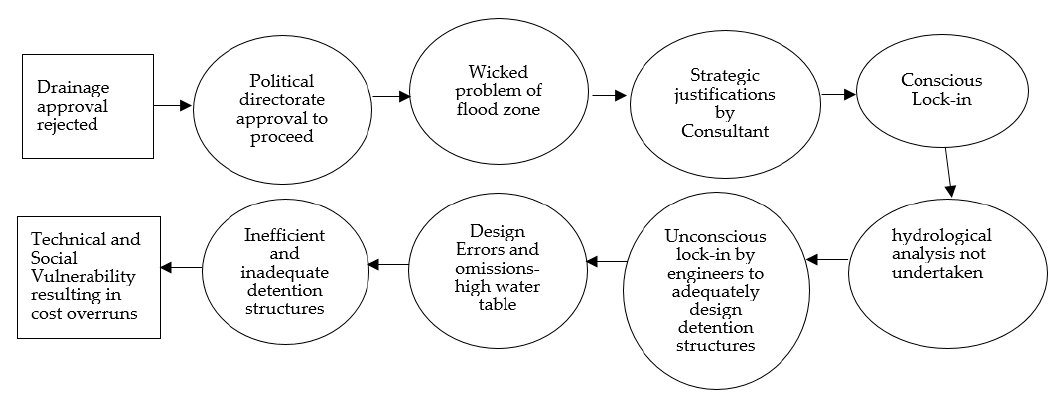
Figure 3. Ineffective decisions creating technical vulnerabilities and cost overruns.